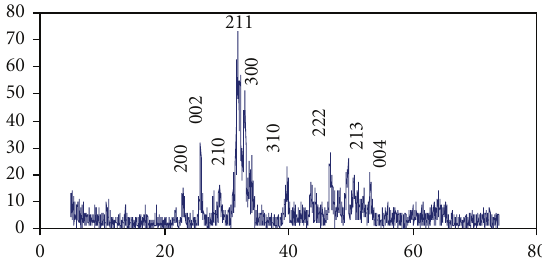
Figure 1: XRD pattern of HAP nanorods. Figure 2: FT-IR spectra of synthesized hydroxyapatite.